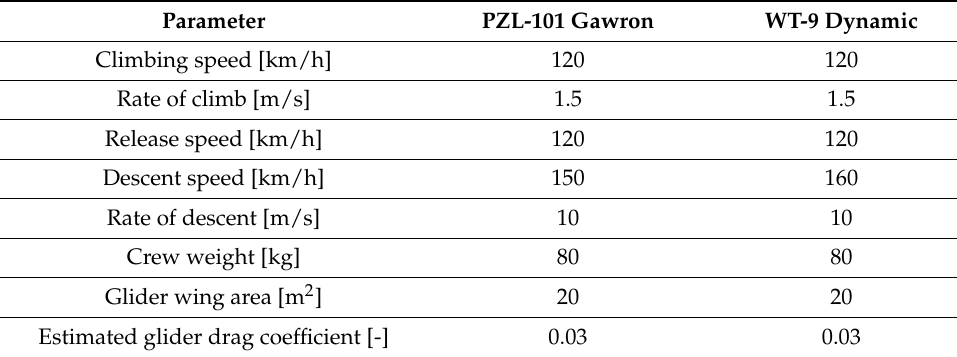
Table 6. Glider towing